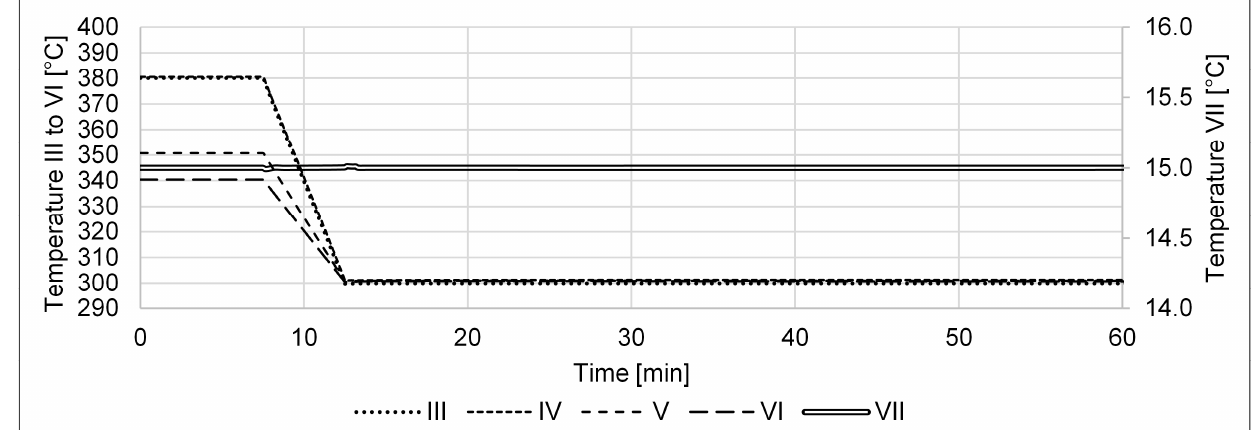
Figure 27 . Temperatures of selected streams of scenario (j). Figure 27. Temperatures of selected streams of scenario (j).